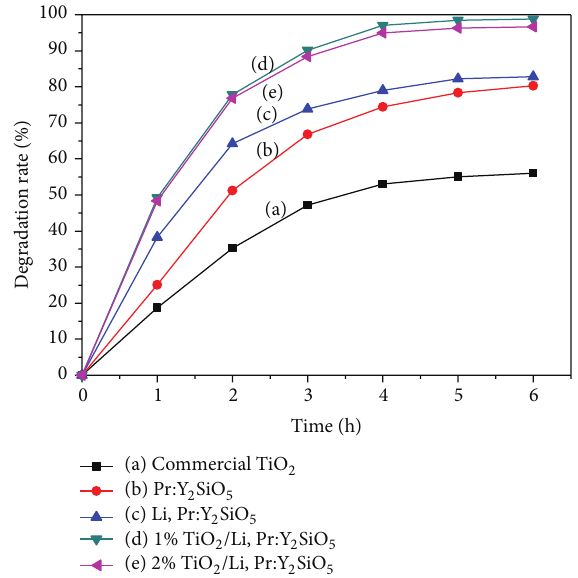
Figure 6: The photodegradation performances of nanomaterial samples. (a) Commercial TiO 2 ; (b) Pr:Y 2 SiO 5 ; (c) Li,Pr:Y 2 SiO 5 ; (d) 1% TiO 2 /Li,Pr:Y 2 SiO 5 ; (e) 2% TiO 2 /Li,Pr:Y 2 SiO 5